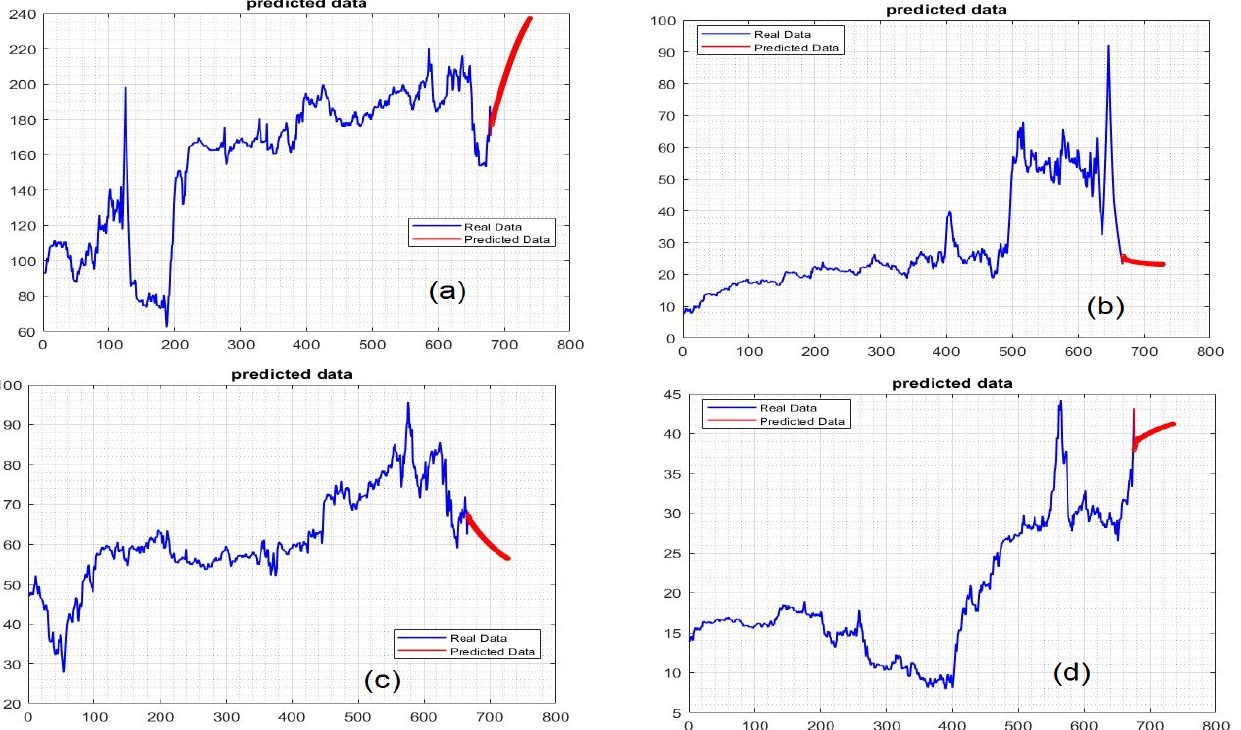
Figure 14. Forecasting values of LSTM model, ( a ) communication ( b ) energy, ( c ) financial and ( d ) industrial sectors.